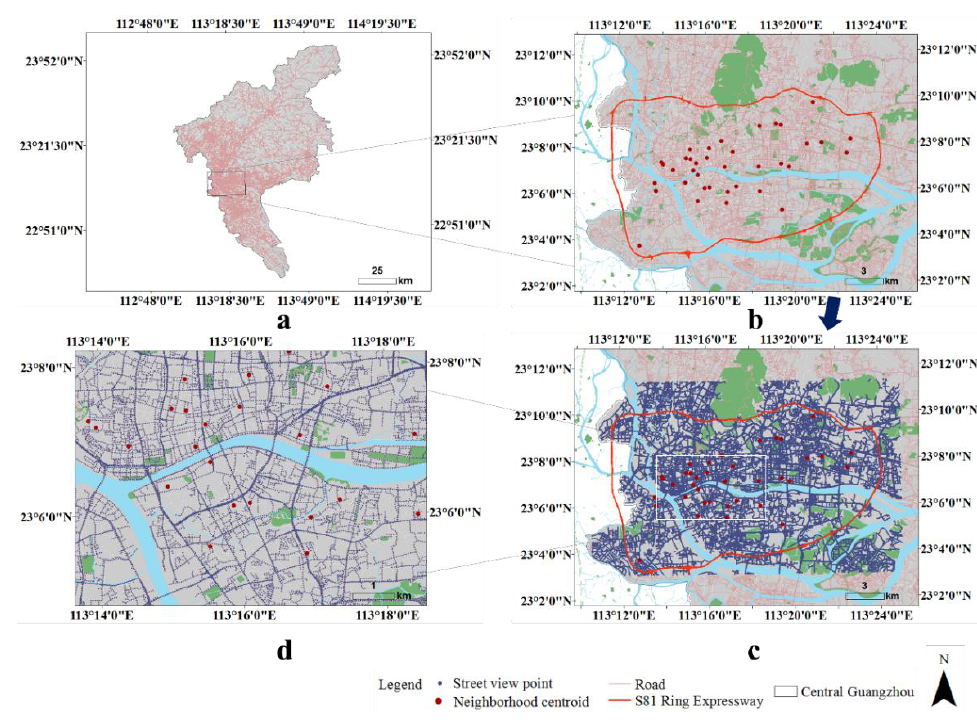
Figure 1. Distribution of sampled points for capturing street greenery images. ( a ) Guangzhou map; ( b ) central Guangzhou; ( c ) 73,289 street-view sample points with purple color; ( d ) a magnified area with street-view sample points).